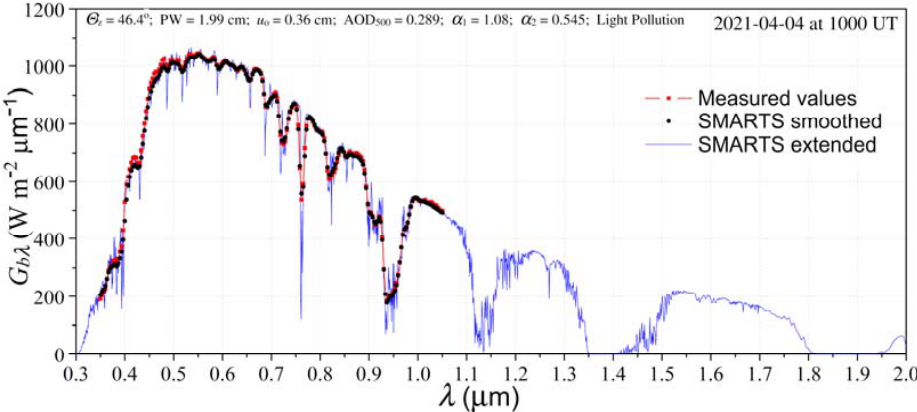
Figure 11. Spectral irradiances at 1000 UTC of 2021-04-04. The retrieved values of some atmospheric quantities used as SMARTS inputs are also indicated, along with the zenith angle ( Θ z ).